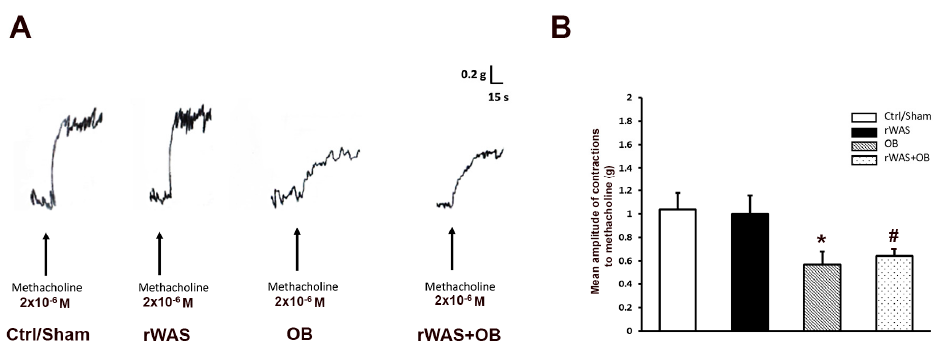
Figure 3. Direct muscular responses elicited by methacholine in strips from the different animal groups. ( A ): Typical tracing showing the muscular contraction elicited by the addition of methacholine to the bath medium in preparations from Ctrl, rWAS, OB, and rWAS+OB rats. Note the similar amplitude of the response in preparations from Ctrl and rWAS animals and its reduction in both OB and rWAS+OB rats. ( B ): Bar chart showing the mean amplitude of the direct contraction induced by methacholine in preparations from Ctrl/Sham, rWAS, OB, and rWAS+OB rats. The amplitude of the response to methacholine was not statistically different between Ctrl and Sham rats, so all the data were put together and analyzed (Ctrl/Sham) . No statistical differences are present in the mean amplitude of the response to methacholine between preparations from Ctrl/Sham and rWAS rats. At variance, the mean amplitude of the direct response to methacholine appears reduced in preparations from both OB and rWAS+OB rats, without statistical differences between these two groups, in comparison with the Ctrl/Sham and rWAS ones. All values are means ± S.E.M. of 6–8 prepara-